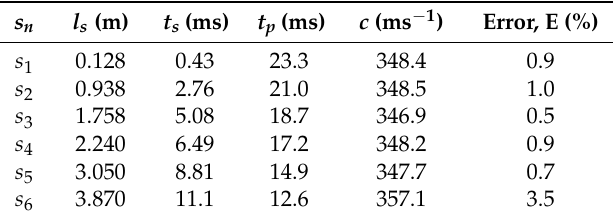
2 × ( 4.12 − 0.128 ) ≈ 348.43 ms − 1 c = ( 23.35 − 0.436 )( × 10 − 3 ) Table 2. Arrival Time of Compression and Rarefaction Wave-front using the acoustic continuum axisymmetric 8-node element (ACAX8).